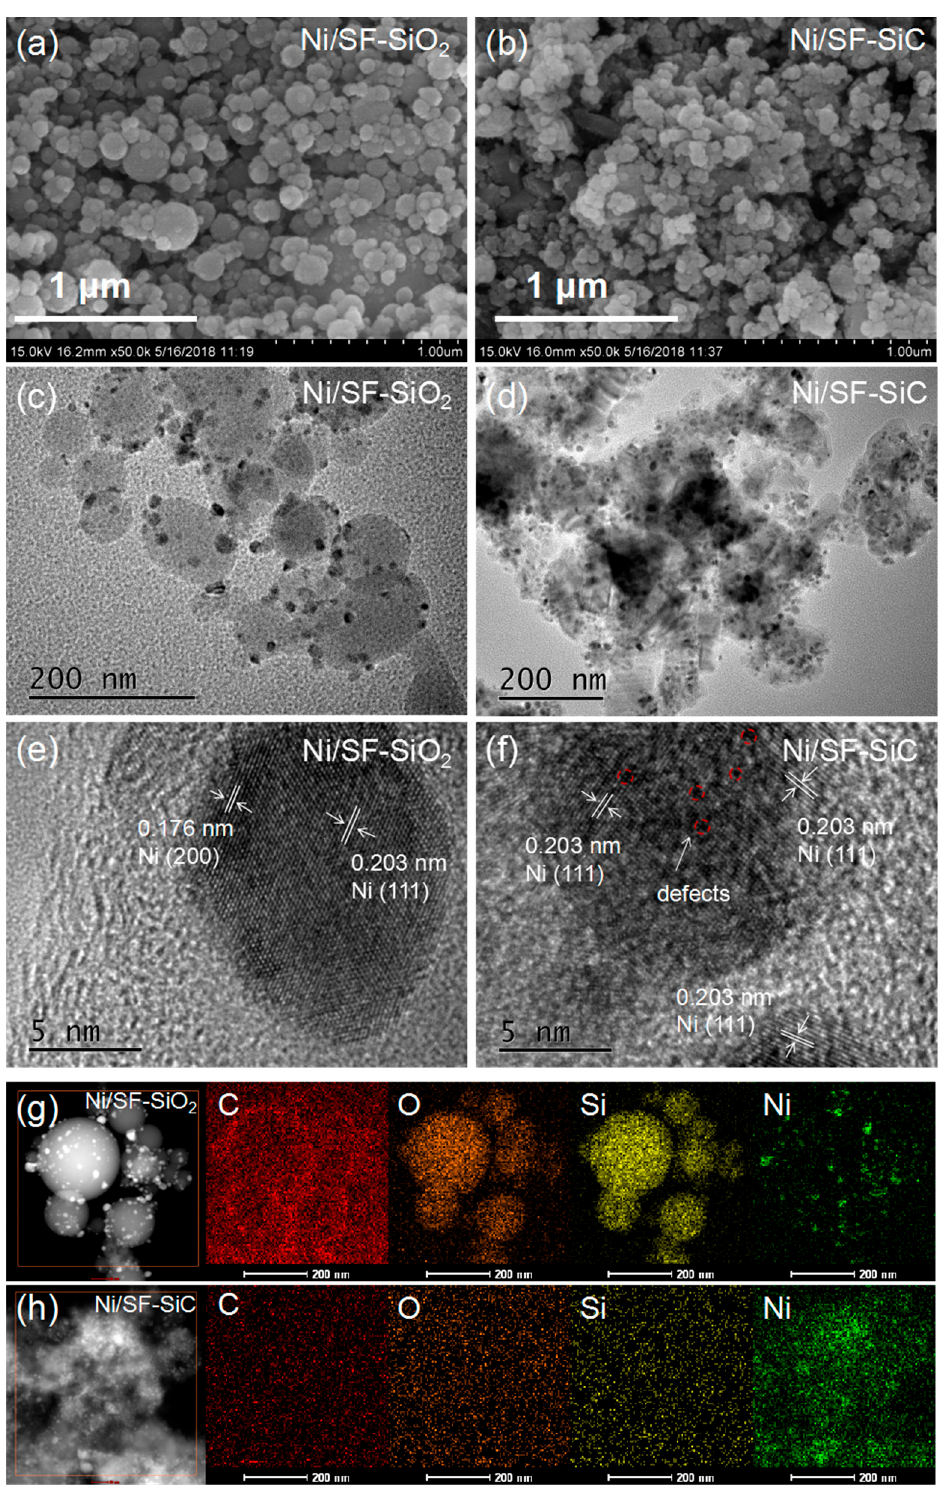
Figure 4. SEM images of the samples: ( a ) Ni/SF ‐ SiO 2 , ( b ) Ni/SF ‐ SiC. HRTEM images of the reduced catalysts: ( c , e ) Ni/SF ‐ SiO 2 and ( d , f ) Ni/SF ‐ SiC. HRTEM elemental mapping images of C, O, Si and Ni of ( g ) Ni/SF ‐ SiO 2 and ( h ) Ni/SF ‐ SiC.